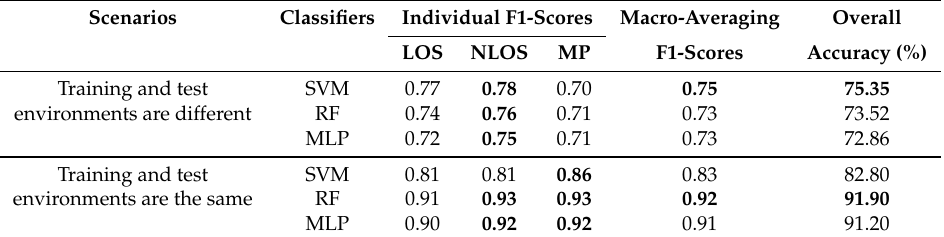
Table 5. Summary of the results based on the F1-scores and overall